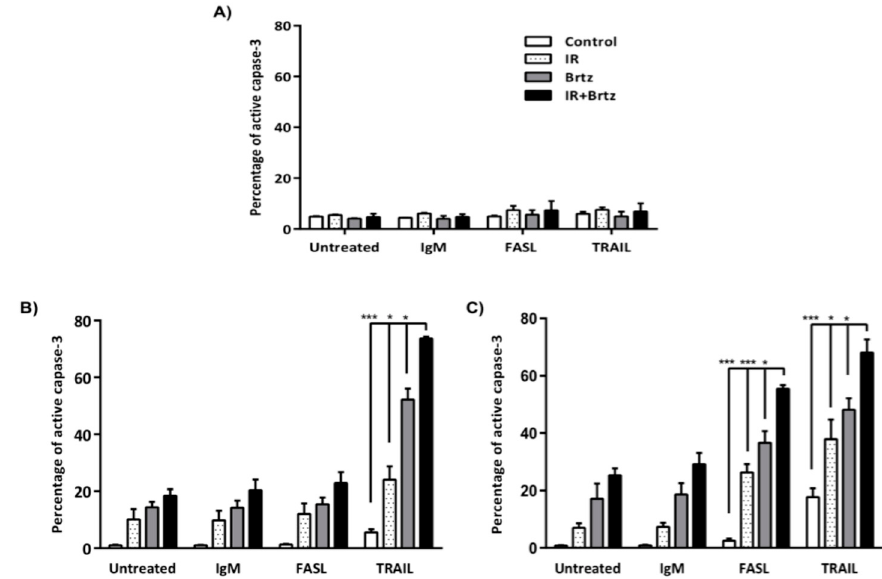
Figure 6. Inhibition of the 26S proteasome and sub-lethal irradiation can enhance sensitivity to killing through FAS and TRAIL receptors in colorectal carcinoma cells, but not in CCD-18Co cells. Tumor cells were mock-irradiated (0 Gy) or irradiated with 5 Gy and cultured for 24 h. Following incubation, mock-irradiated or irradiated cells were treated with 10 nM bortezomib and incubated for an additional 24 h. The tumor cells were then incubated for 3 h with agonistic anti-Fas antibody (FASL) or recombinant TRAIL protein. Control cells were incubated with IgM isotype control antibody. Cells were subsequently fixed and permeabilized before being stained for intracellular active caspase-3 with a PE-labeled monoclonal antibody. The level of activated caspase-3 was evaluated by flow cytometry. Isotype control stained cells were analyzed for each treatment group individually and set to 5% positive. Graph shows average of three independent experiments, with error bars denoting SEM * p < 0.05, *** p < 0.0005. Percentage of active caspase-3 in ( A ) CCD-18Co, ( B ) SW620, ( C ) and HTC116 cells inhibition sensitizes tumor cells to Fas or TRAIL mediated killing possibly through enhancing cell surface expression of death receptors, which sensitizes tumor cells to killing by their ligands.